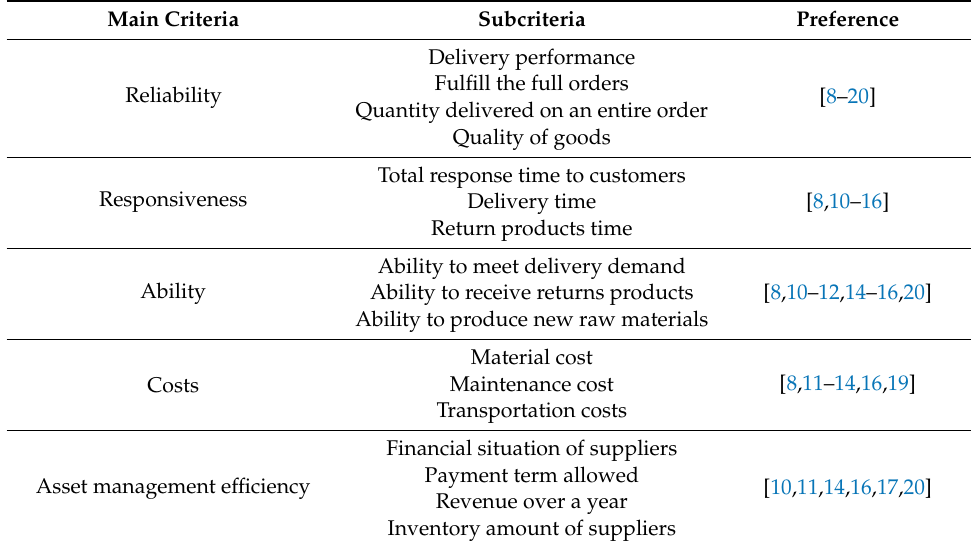
Table 1. Themain andsub-criteria are definedbased onthe supplychain operationreference